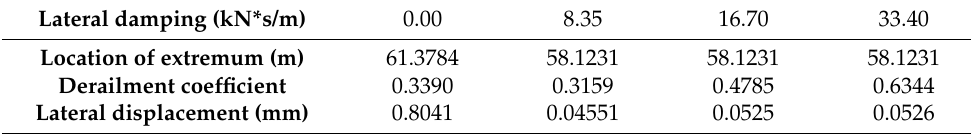
Table 2. Extreme values of calculation results under different lateral damping conditions.